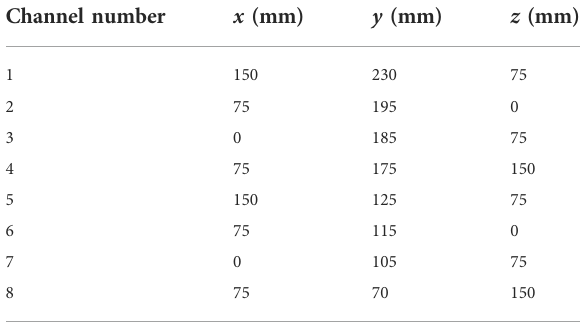
FIGURE 8 RC cylinders ’ condition after electrical corrosion in uncoated